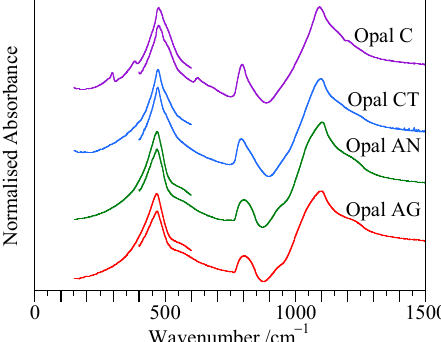
Figure 4. Transmission spectra of examplars prepared as a suspension in CsI disc: (red) opal-AG (G13771 from White Cliffs, Australia), (green) opal-AN (G32740 hyalite from Valec, Chechia), (blue) opal-CT (G9942) from Angaston, Australia) and (purple) opal-C (M5081 from Iceland). Spectra have been normalised to the 470 cm − 1 band. Far- and mid-range IR spectra are from different instruments and are offset for clarity. Table 3. Transmission mode spectra (CsI disc) peak positions. The uncertainty value represents the range of values observed for various samples.